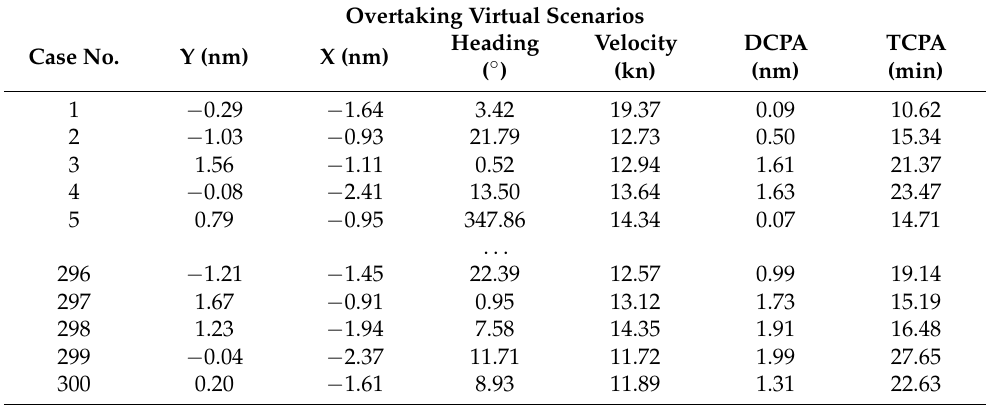
Table 6. The virtual scenarios generated for overtaking encounter. Overtaking Virtual Scenarios Case No.